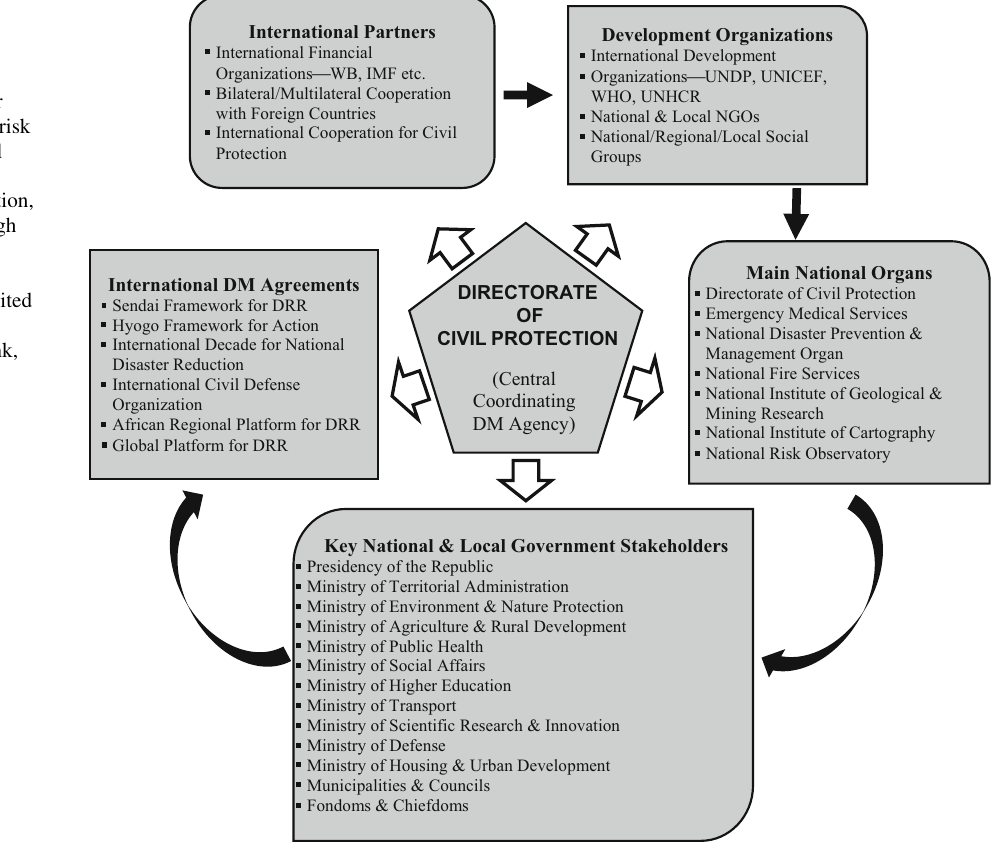
Fig. 2 Cameroon’s